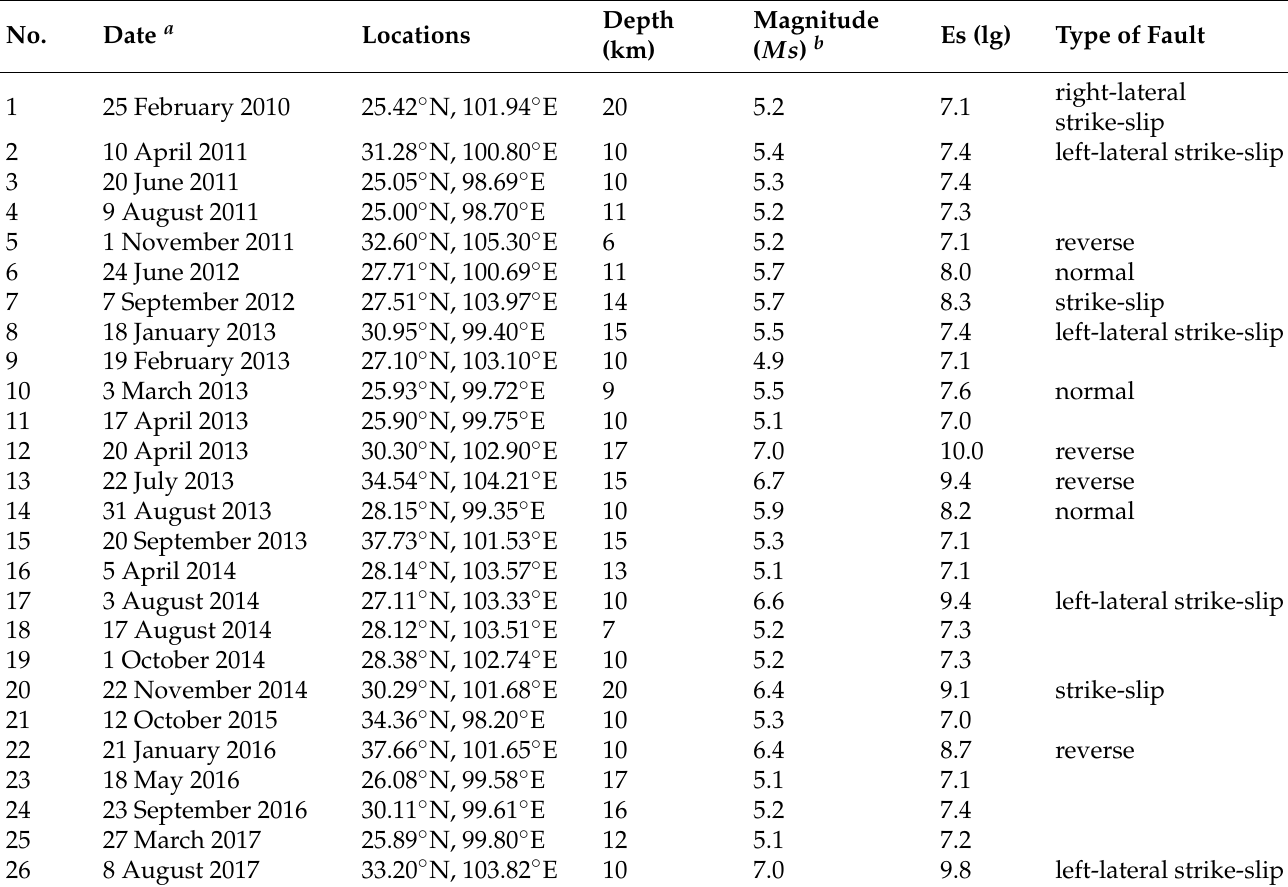
Figure 2. From top to bottom are variations of the seismicity, the E s parameter and daily network degree during 2010-2017, respectively. The pink horizontal line indicates E s = 10 7 . Table 2. List of earthquakes with E s ≥ 10 7 in the study